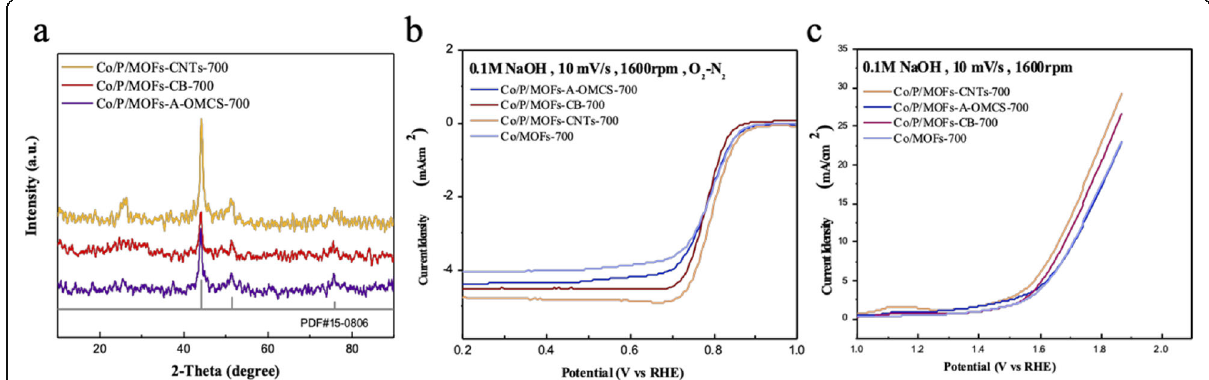
Fig. 7 a XRD patterns of Co/P/MOFs-CNTs-700, Co/P/MOFs-A-OMCS-700, and Co/P/MOFs-CB-700. b , c ORR and OER LSV curves for the above samples,